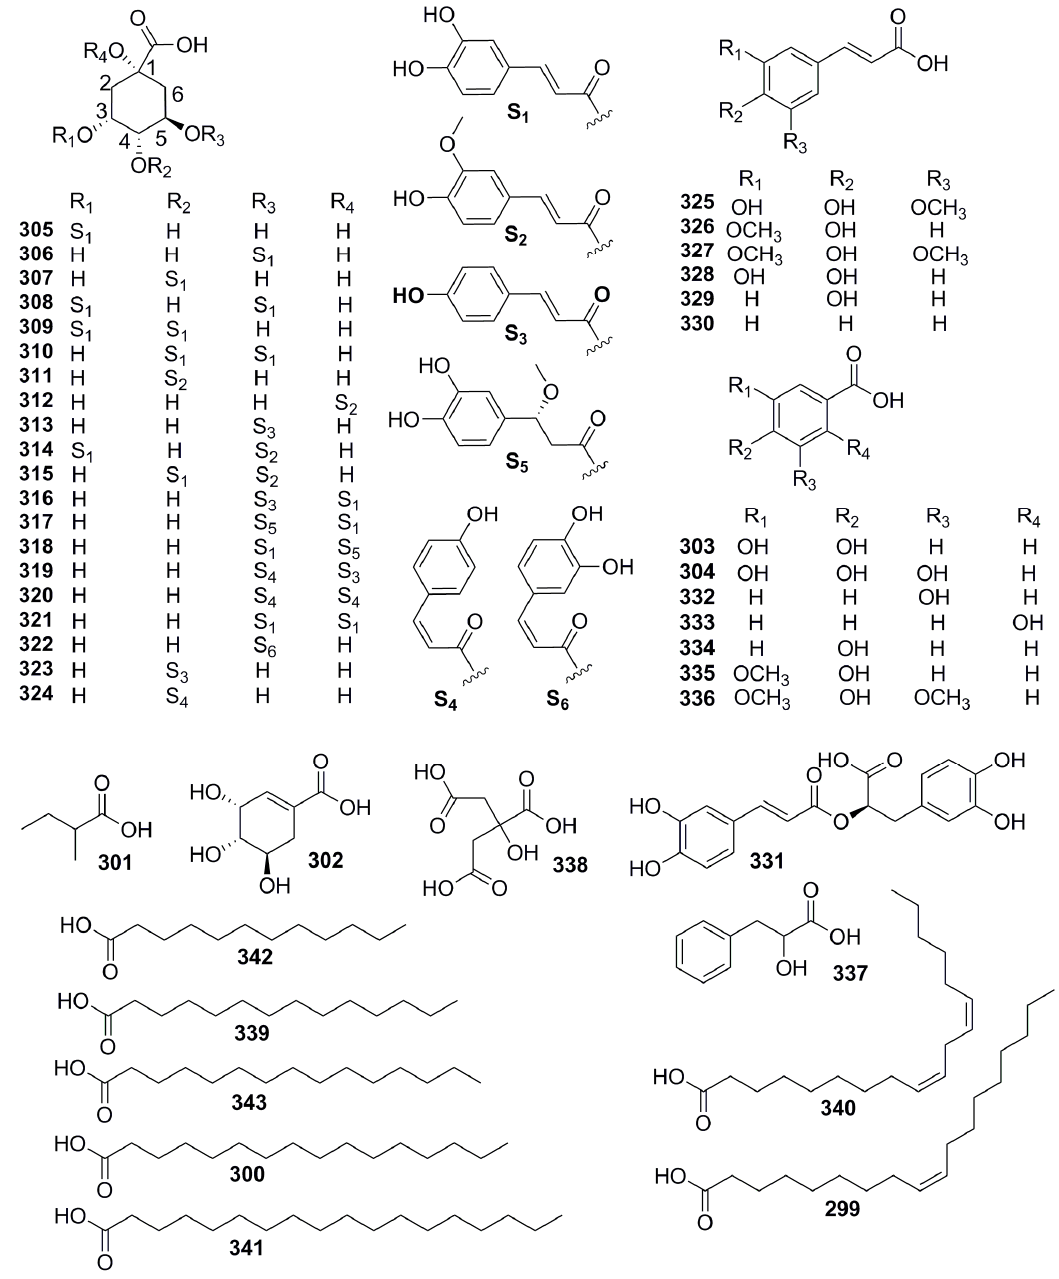
Figure 8. Chemical structures of organic acids.